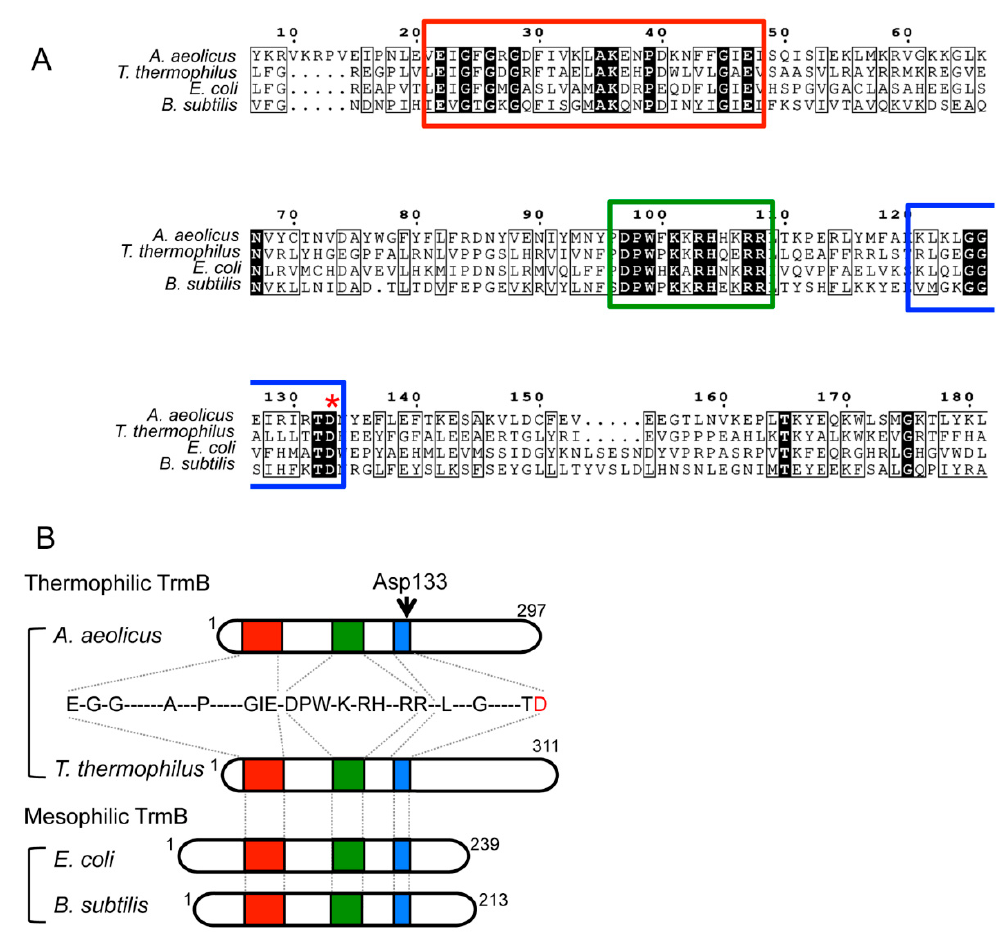
Figure 3. Comparison of thermophilic and methophilic TrmB. ( A ) Sequence alignment of TrmB. Conserved regions are highlighted in three colored squares (red, green, blue). Asp133 is indicated by an asterisk. ( B ) Thermophilic and mesophilic TrmB proteins are illustrated schematically. The three colored regions correspond to the amino acid sequences in panel A. Thermophilic TrmB has a distinct long C-terminal region. Asp133 is highlighted with an arrow, and the red D corresponds to the Asp133.